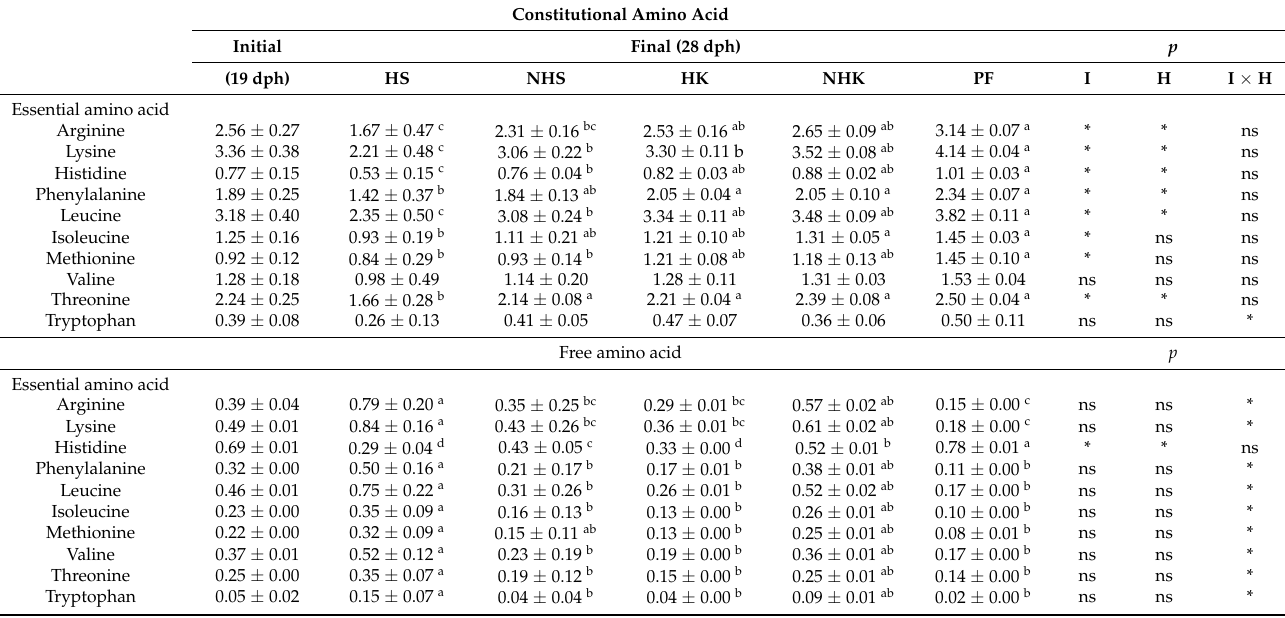
Table 7. Constitutional and free amino acid content of Pacific bluefin tuna fed the test diets 1 for 9 days (g/100 g, dry-weight). Constitutional Amino